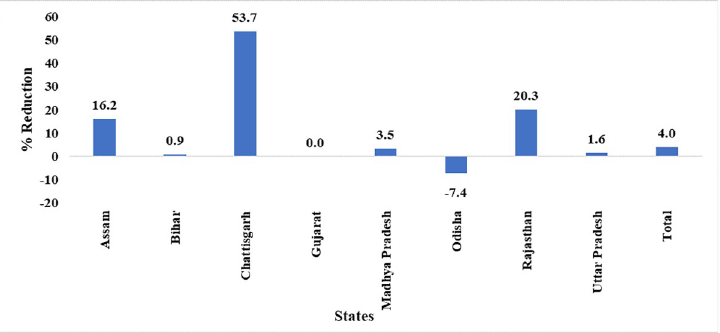
Fig 3. State-wise reduction in minimum stock-out of vaccines a . a Data of Jharkhand, Manipur, Nagaland and Himachal Pradesh are not presented as the number of CCPs from these states are less than 30.